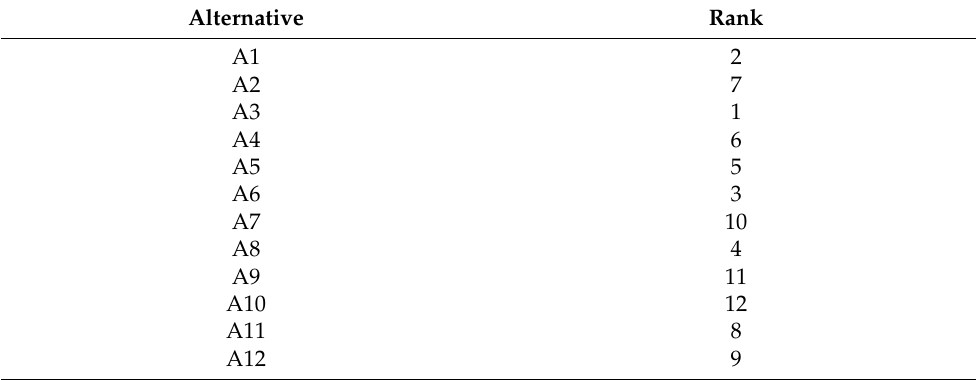
Table 18. Alternatives ranked according to the descending order of obtained traces.